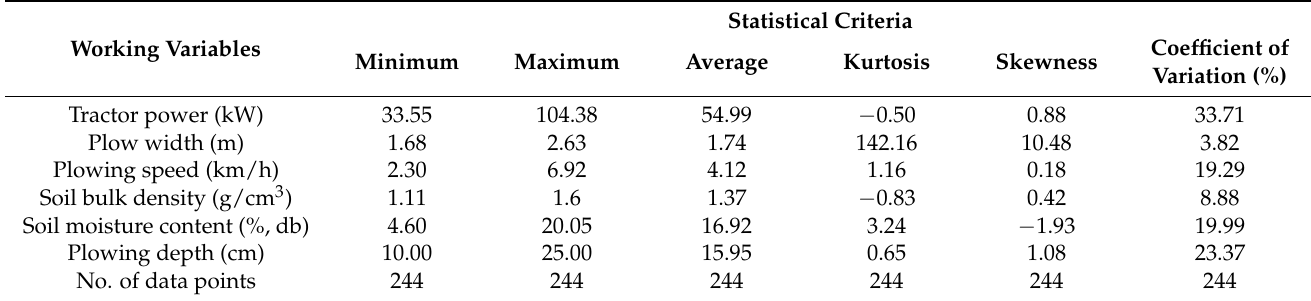
Table 2. Statistical criteria of the working variables for literature and experimental work.